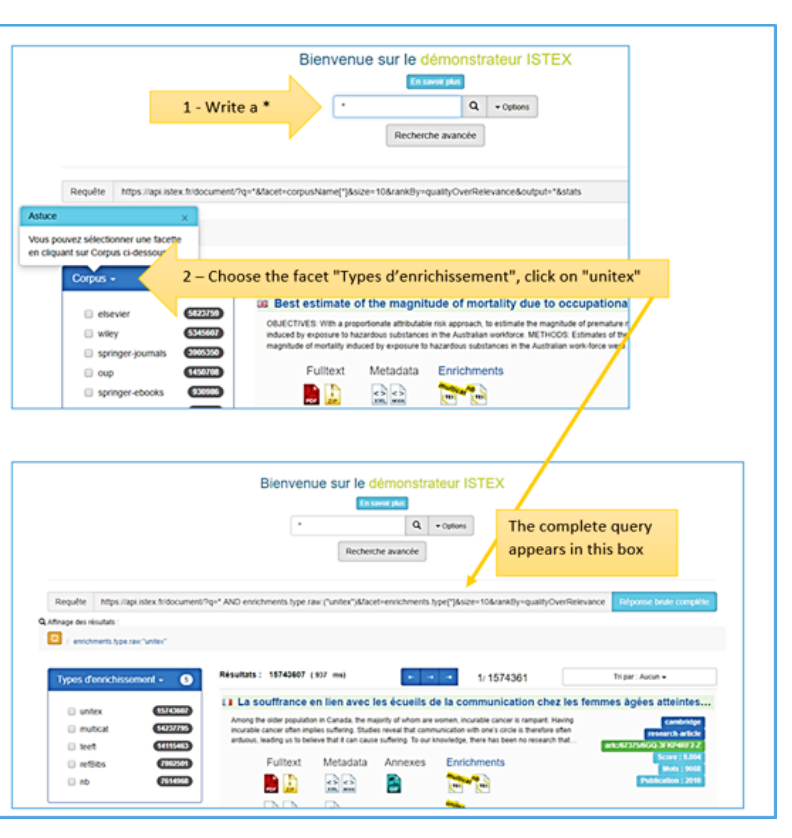
Figure 4. Procedure for obtaining the complex query to find out the number of documents containing Unitex